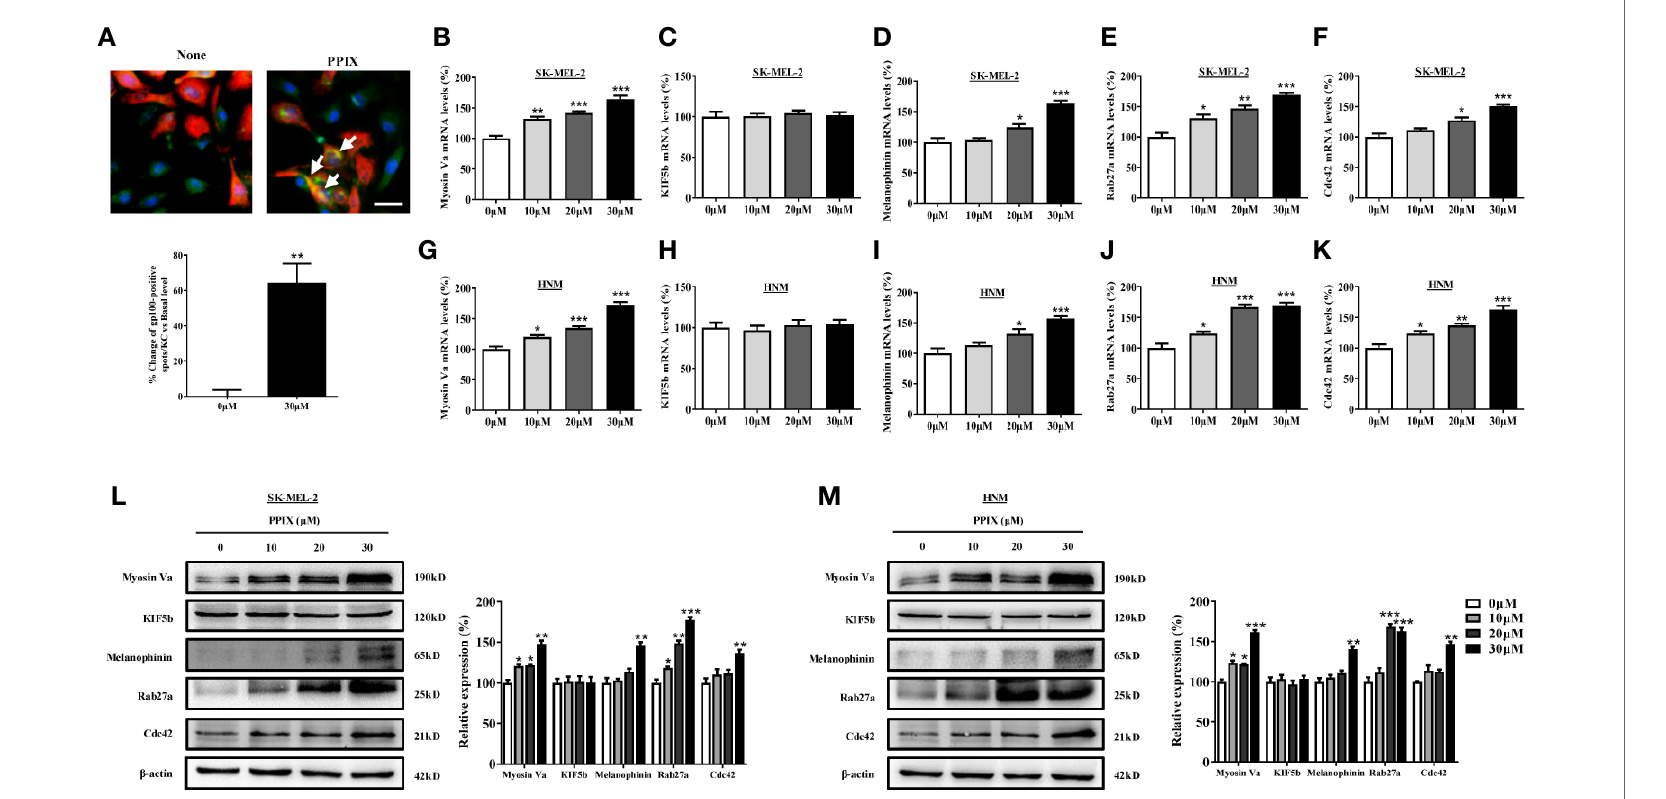
FIGURE 3 | PPIX induced melanosome transport in melanocytes. (A) In cocultured SK-MEL-2 and HaCaT cells, melanosome with yellow signal (arrow) were evident in cytokeratin-positive HaCaT cells. Melanosome labeling with GP100 (green). HaCaT cells labeling with cytokeratin (red). Bar = 20 m m. Quanti fi cation of melanosomes transferred to HaCaT cells. Twenty cells per condition were assessed in each of three independent experiments. SK-MEL-2 cells and HNM were treated with PPIX (10, 20, and 30 m M) for 12 hours, and RT-qPCR was then applied to detect myosin Va (B , G) , KIF5b (C , H) , melanophinin (D , I) , Rab27a (E , J) , and Cdc42 (F , K) gene expression. (L) SK-MEL-2 and (M) HNM cells were treated with PPIX (10, 20, and 30 m M). After 48-h treatment, the expression levels of myosin Va, KIF5b, melanophinin, Rab27a, and Cdc42 were examined. The results were shown as relative values to the control. Data are expressed as the mean ± SEM (n = 3). *p < 0.05, **p < 0.01, ***p < 0.001 versus non-treated